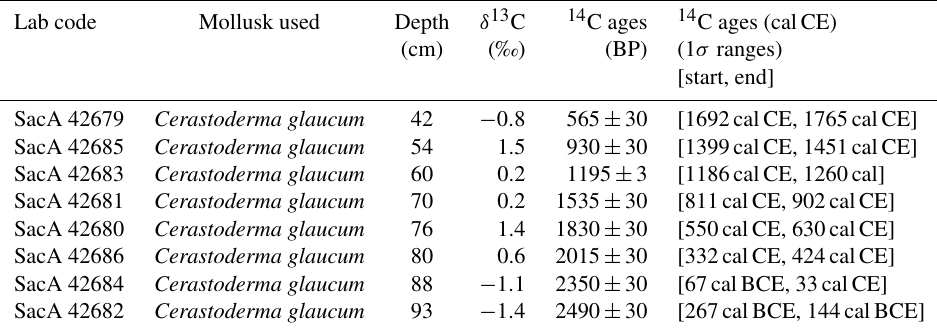
Figure 4. Distribution profile of 210 Pb ex , Pb, and 137 Cs vs. depth in GEM4. The 210 Pb data present a sedimentation rate of 0.6mmyr − 1 . The activity depth profile Cs indicates a peak at 3cm, determining accumulation rates of 0.6mmyr − 1 for the 1963 depths. Table 1. 14 C data for shells from GEM3. The model ages were determined by OxCal. The 14 C ages are calculated and calibrated using the curve of Marine13 calibration with reservoir age.